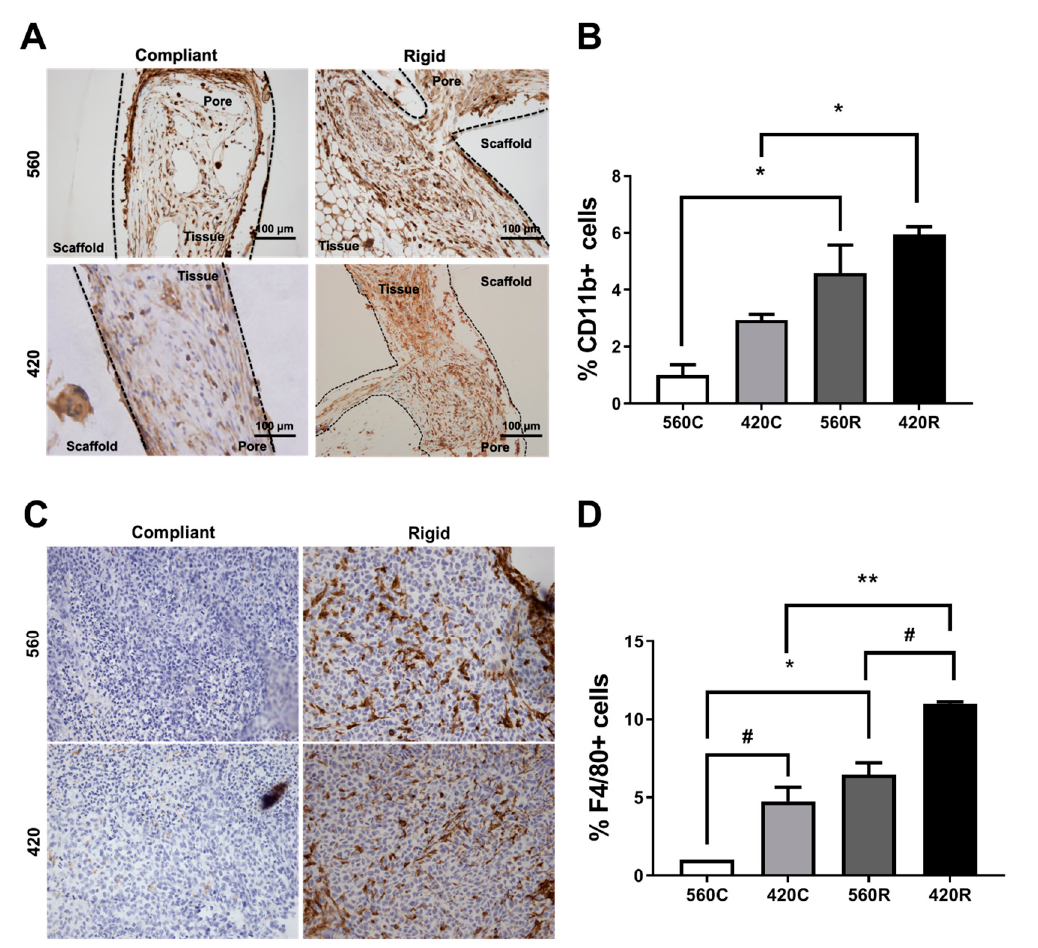
Figure 6. Effects of substrate modulus and pore size on immune infiltration in a xenograft model. Representative immunohistochemistry images show scaffolds with pores outlined by dashed lines. Tissue infiltrated inside pores is shown by Hematoxylin staining, and positive immunohistochemical staining is represented by dark brown staining. ( A ) Representative 20× images and ( B ) quantification of immunohistochemistry staining for CD11b in 3D scaffolds show increased CD11b+ cell populations in 560R (5-fold) and 420R (6-fold) scaffolds compared to compliant scaffolds. ( C ) Representative 20× images and ( D ) quantification of immunohistochemistry staining for F4/80 in 3D scaffolds reveal increased populations of F4/80+ cells in 560R (7-fold) and 420R (10-fold) as well as a noticeable increase in staining with decreasing pore size. All data was normalized to 560C. Compliant vs. rigid * p < 0.05, ** p < 0.01. 560 vs. 420, # p < 0.05.